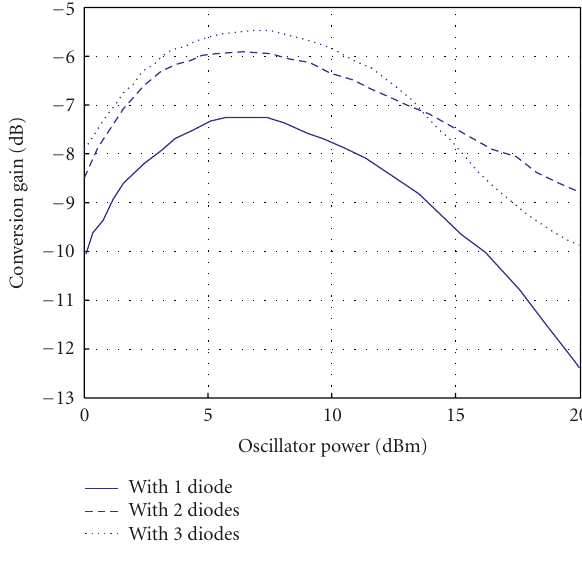
Figure 5: Mixer conversion gain.